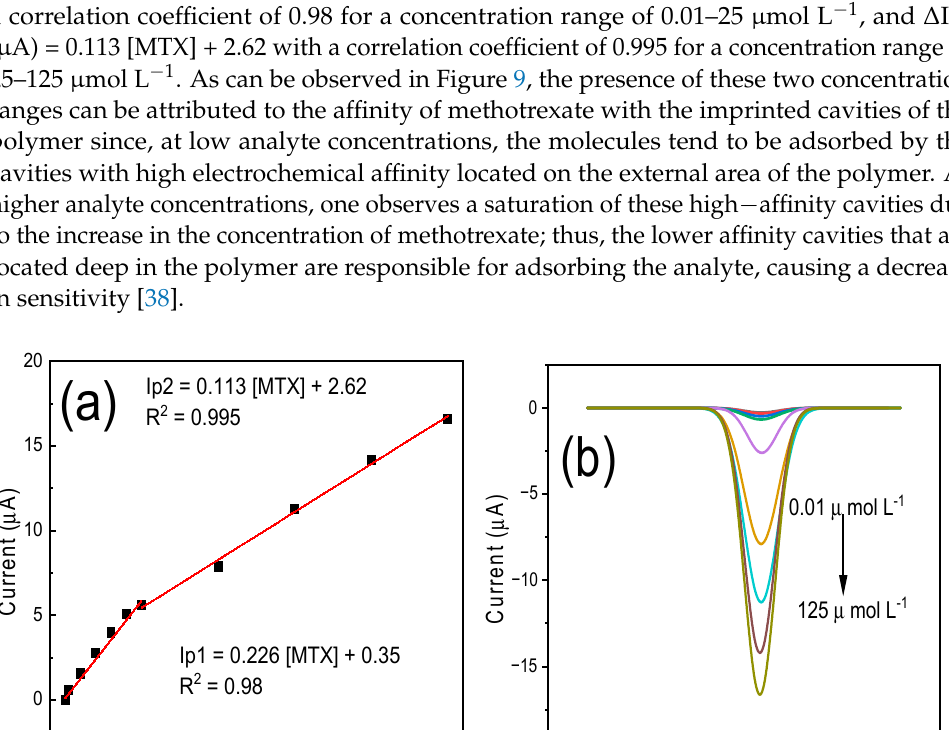
Figure 8. DP voltammograms obtained from the application of 100 µ mol L − 1 MTX at different pH levels of PBS. Range of pH investigated: 3 ( a ), 5 ( b ), 7 ( c ), and 9 ( d ).